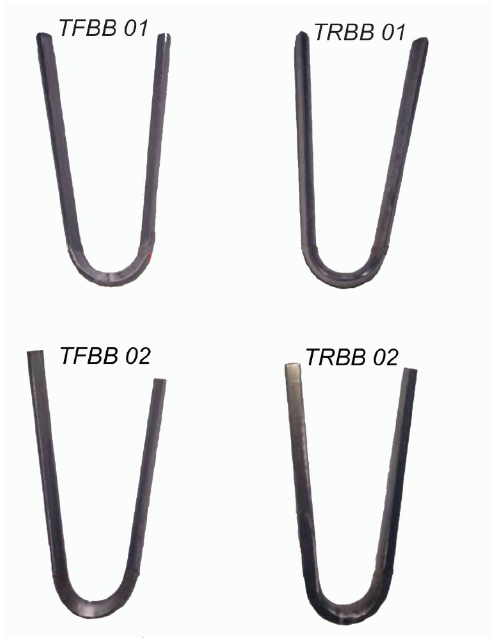
Figure 5. Specimens after bending tests.